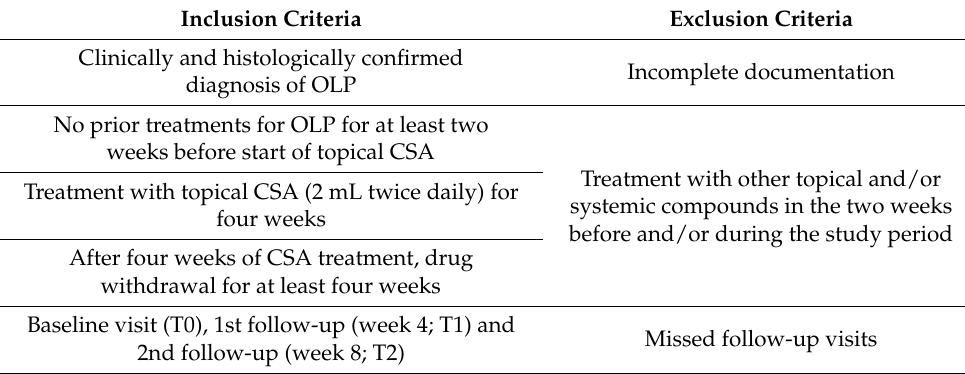
Figure 1. Flow chart of inclusion process. OLP: oral lichen planus; CSA: cyclosporine. Table 1. Inclusion and exclusion